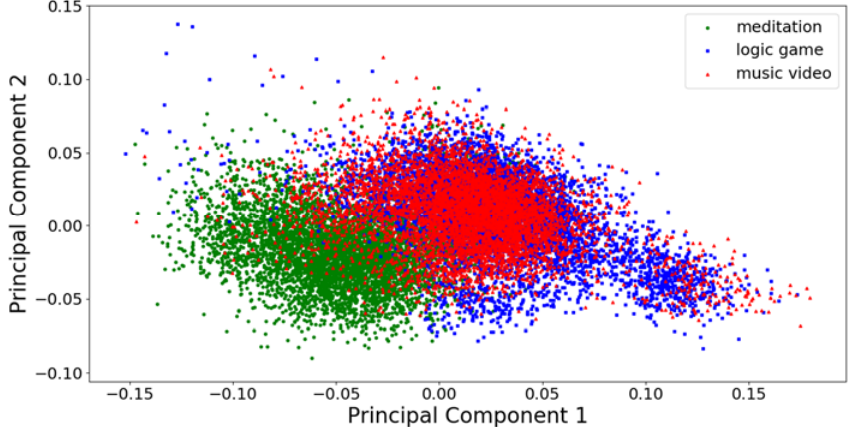
Figure 2. First (x-axis) and second (y-axis) principal component of the training dataset parametrized Figure 2. First (x ‐ axis) and second (y ‐ axis) principal component of the training dataset parametrized with the welch32 scheme. Sensors 2020 , 20 , x FOR PEER REVIEW with the welch32 scheme.